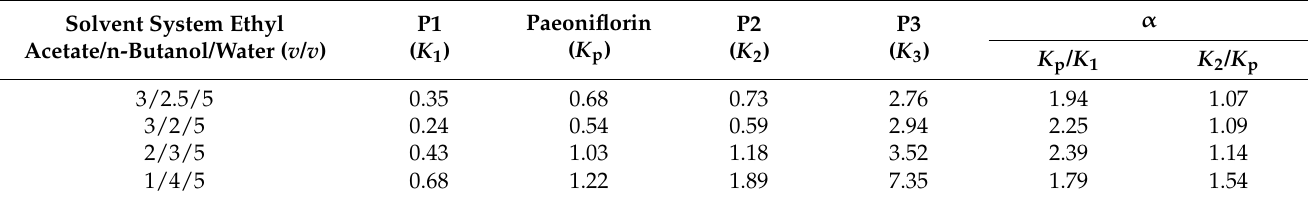
Table 2. Partition coefficients (K) and separation factors ( α ) of the four components in four solvent